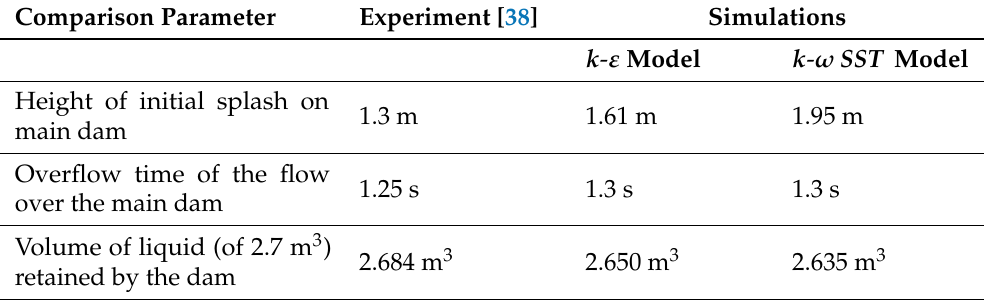
Table 2. Comparison of measured and calculated parameters for a flow in a chute with three dams.